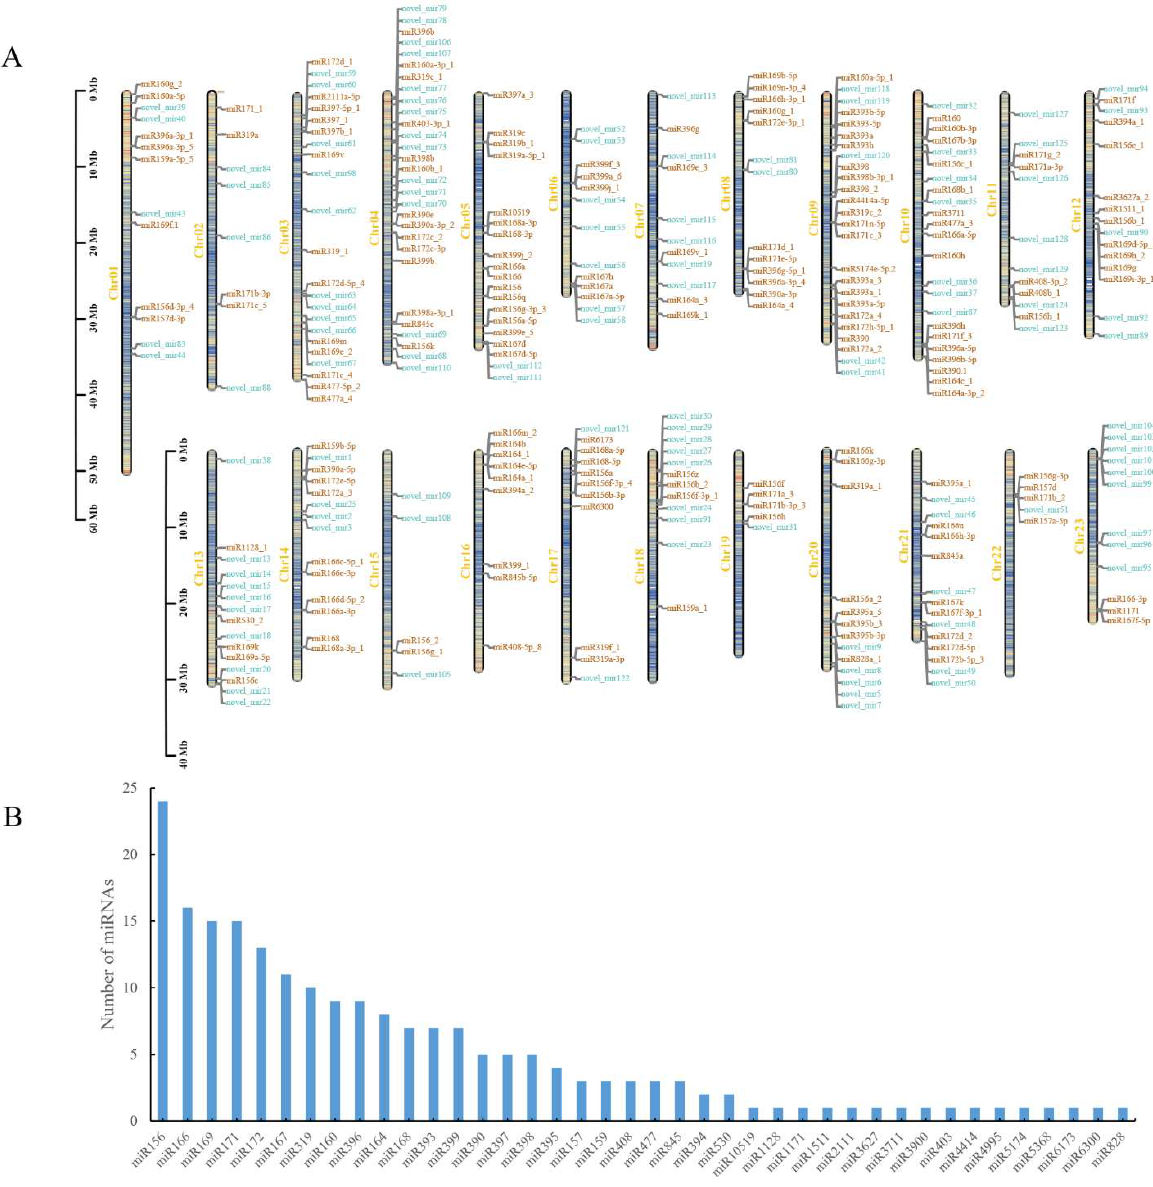
Figure 2. Localization of miRNAs on chromosomes and family analysis of conserved miRNAs. ( A ) Localization of identified miRNAs on the chromosomes. Orange and blue fonts indicate the known mature miRNAs and novel miRNAs, respectively. ( B ) The 40 families of conserved